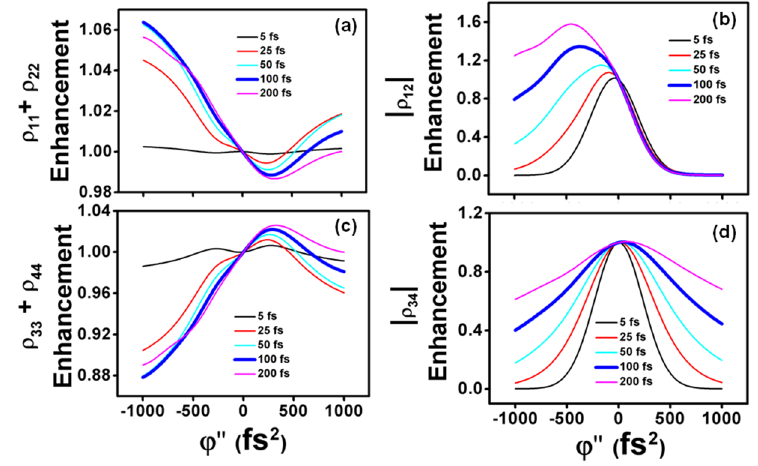
Figure 7. Influence of electronic dephasing ( T 2,elec = 5 fs, 25 fs, 50 fs, 100 fs and 200 fs, as indicated) on the enhancement of ( a ) population in the ground state; ( b ) vibrational coherence in the ground state; ( c ) population in the upper state; and ( d ) vibrational coherence in the upper state, considering an excitation frequency of 19,700 cm − 1 . The bold blue lines show the electronic dephasing time T 2,elec = 100 fs for a clearer comparison with Figure 5.